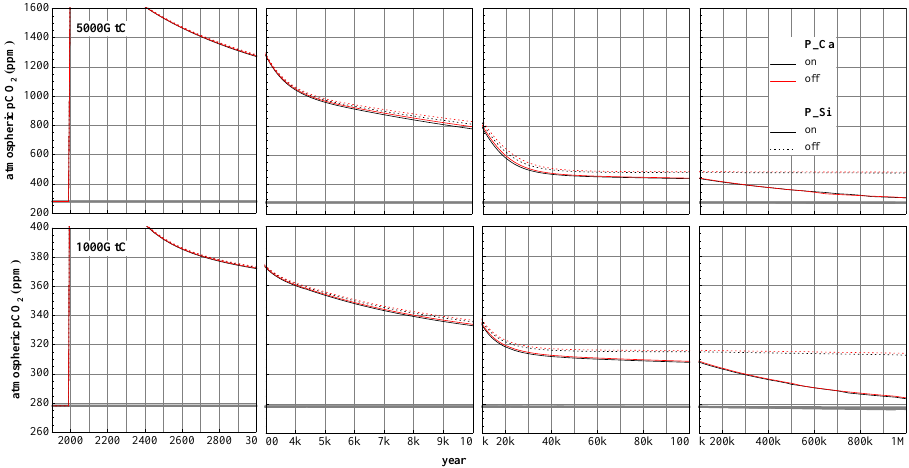
Fig. 13. Evolution of atmospheric CO 2 over 1Myr for 1000GtC (bottom) and 5000GtC (top) emissions pulses, vs. a control run with no emissions (grey lines), with carbonate and silicate weathering-productivity feedbacks (P_Ca and P_Si respectively) on/off.